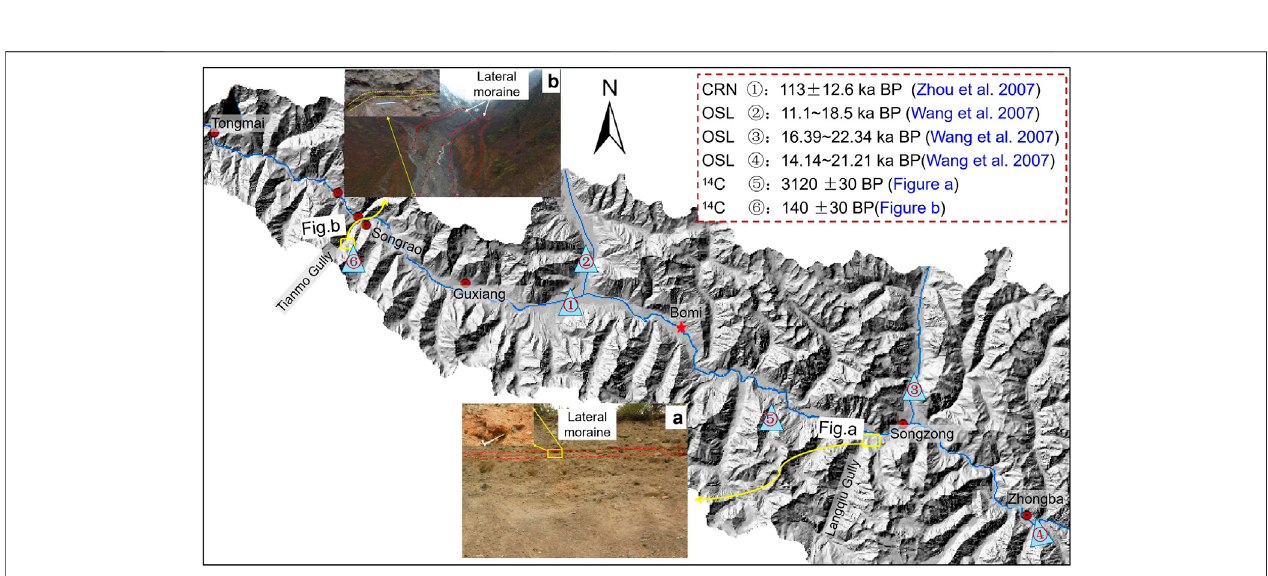
FIGURE 4 | Locations and ages of moraine dating samples at the Parlung Tsangpo basin. The Cosmogenic Radio Nuclide (CRN) age is from Zhou et al (2010), Optical Stimulated Luminescence (OSL) ages are from Wang et al., 2005 and 14 C ages are from testing in this study. (Site A is located at the lateral moraine in the intersection of Langqiu Gully and Parlung Tsangpo river. Site B is located at the lateral moraine at the end of glacier in Tianmogou Gully).